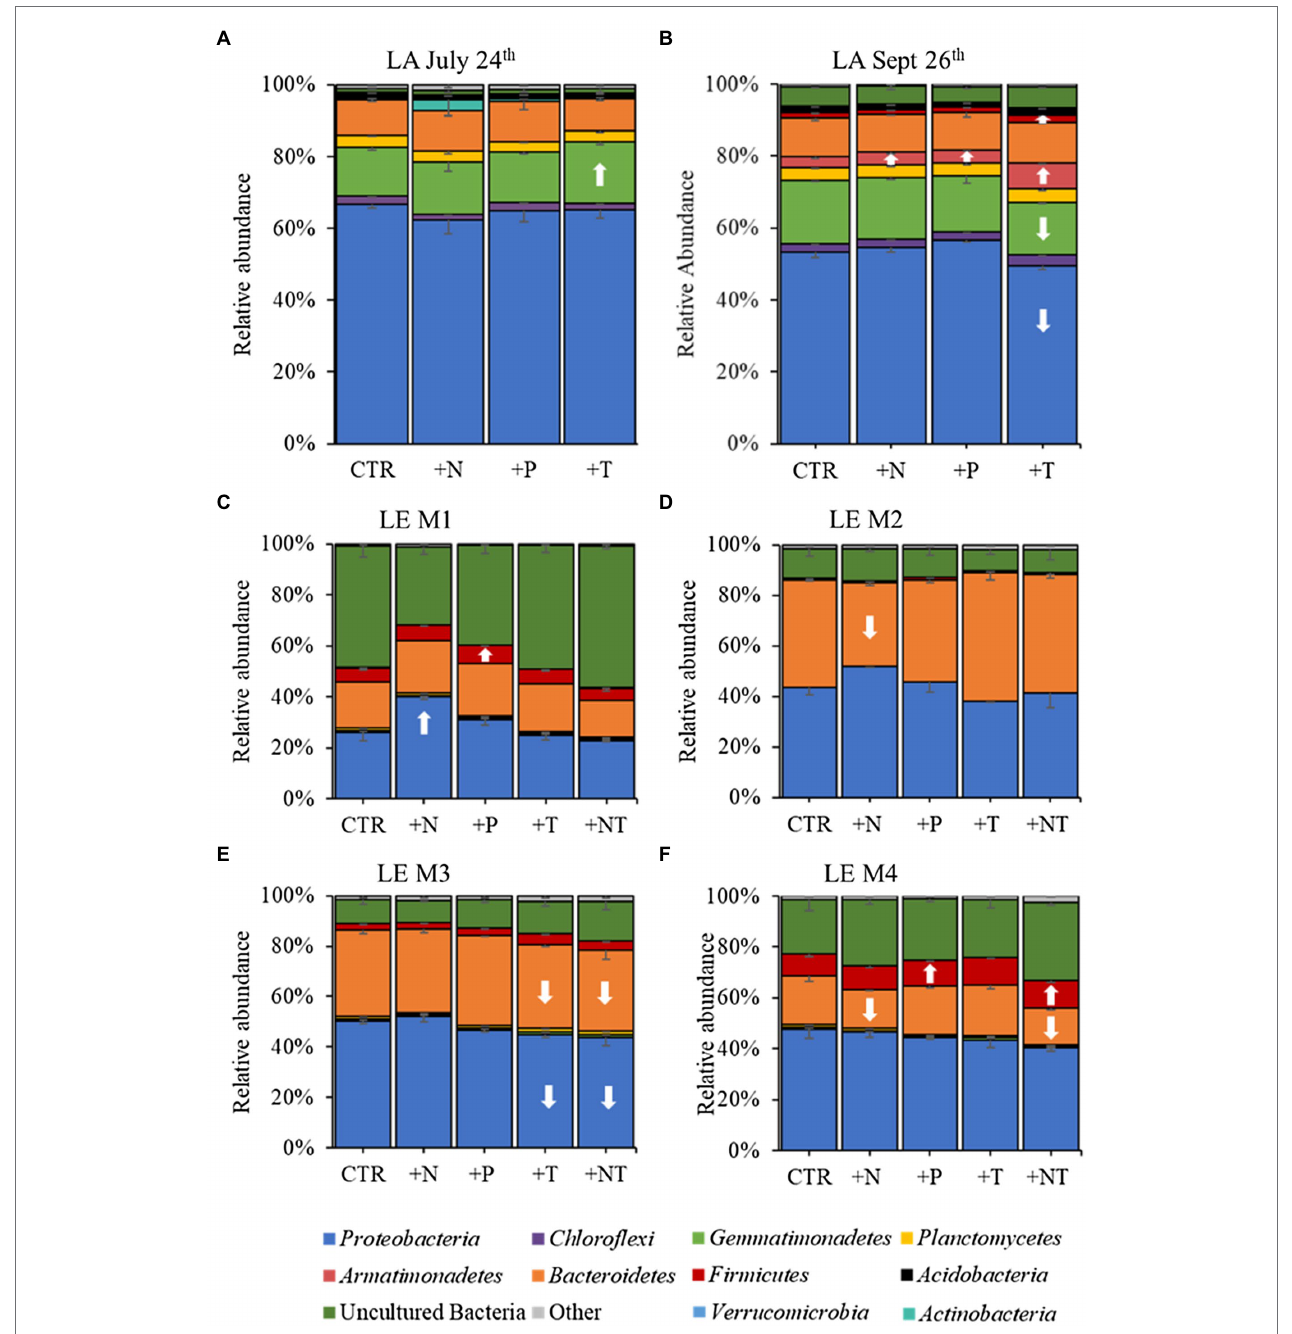
FIGURE 3 | 16S rRNA derived relative abundances of bacterial phyla in the (A) LA July 24th, (B) LA September 26th, (C) LE M1, (D) LE M2, (E) LE M3, and (F) LE M4 experiments. All low abundance phyla have been grouped into the “Other” category. Arrows indicate a significant increase (up) or decrease (down) of the respective phylum in each treatment (CTR, Control; +N, Nitrate addition; +P, Orthophosphate addition; +T, elevated incubation temperature) compared to the